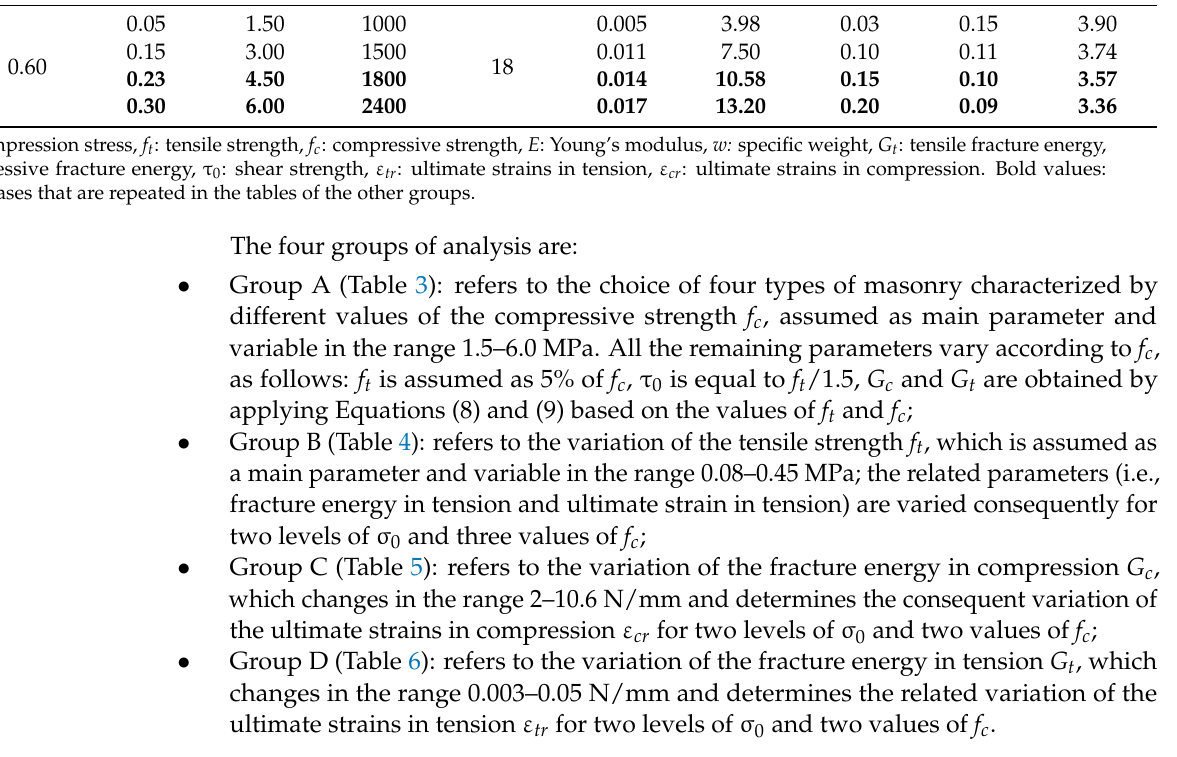
Table 4. Mechanical properties used in the sensitivity analyses for Group B. Group